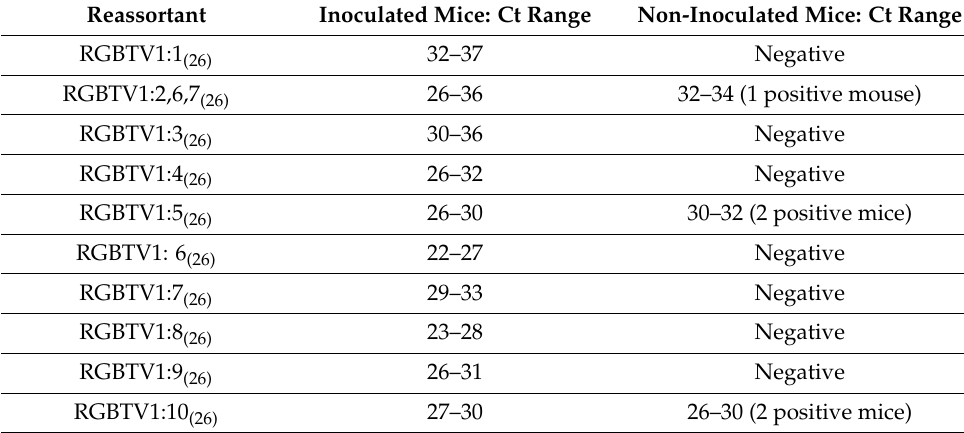
Table 4. Ct values of the RNA extracted from mice inoculated with the reassortants of BTV-26 in the BTV-1RG C7 backbone and from non-inoculated in-contact mice. Ct values ranged from 23 to 37. Positive in-contact mice were identified in the groups inoculated with RGBTV1:2,6,7 (26) , RGBTV1:5 (26) or RGBTV1:10 (26)